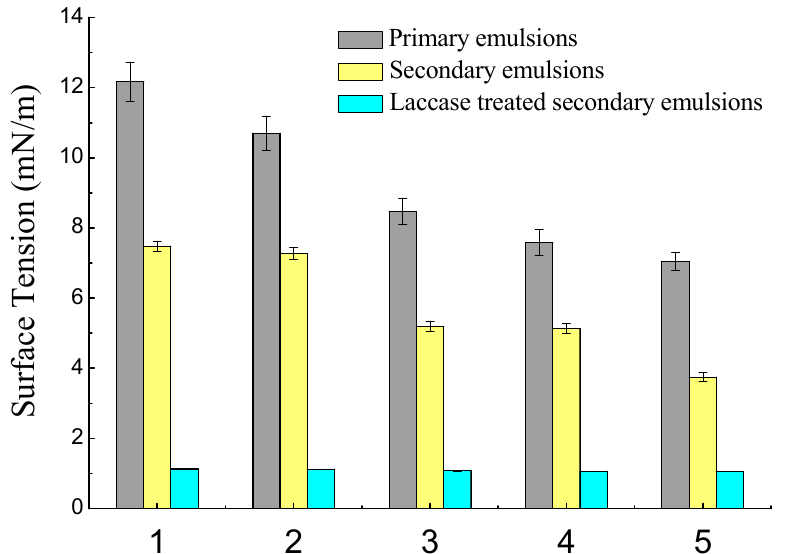
Figure 1. Interfacial tension of primary emulsions (1, 2, 3, 4, and 5 represent protein content of 0.8 g/100 g, 1.8 g/100 g, 2.8 g/100 g, 3.8 g/100 g, and 4.8 g/100 g, respectively); secondary emulsions (protein content was 3.8 g/100 g, and 1, 2, 3, 4, and 5 represent sugar beet pectin (SBP) content of 0.01 g/100 g, 0.02 g/100 g, 0.05 g/100 g, 0.10 g/100 g, and 0.15 g/100 g, respectively); laccase-treated secondary emulsions (protein content was 3.8 g/100 g, SBP content was 0.10 g/100 g, and 1, 2, 3, 4, and 5 represent laccase content of 2 U/100 g, 4 U/100 g, 6 U/100 g, 8 U/100 g, and 10 U/100 g, respectively).